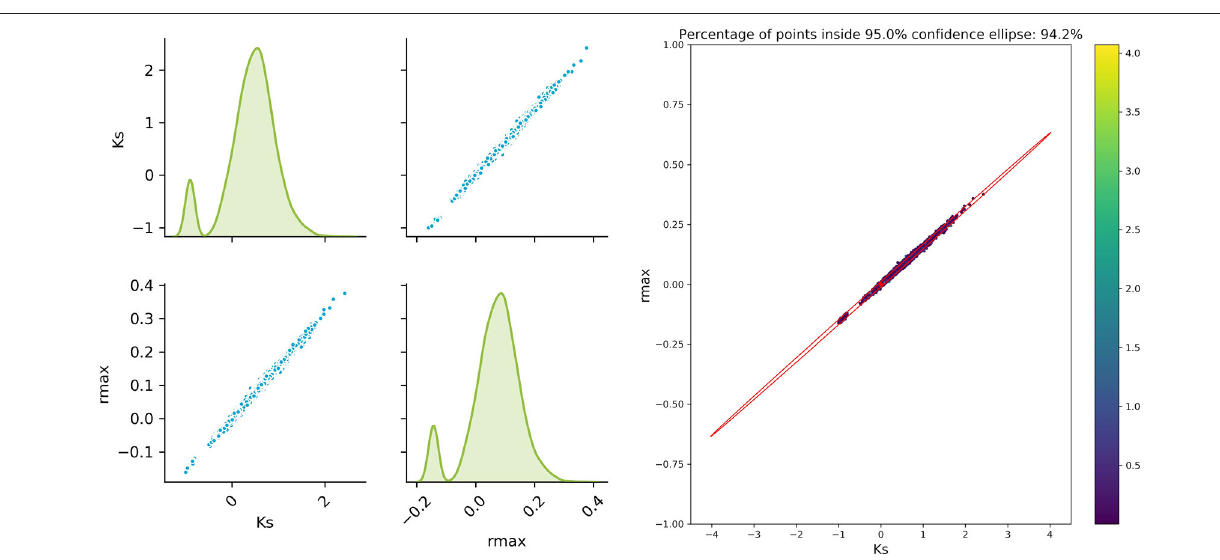
Frontiers in Bioengineering and Biotechnology |